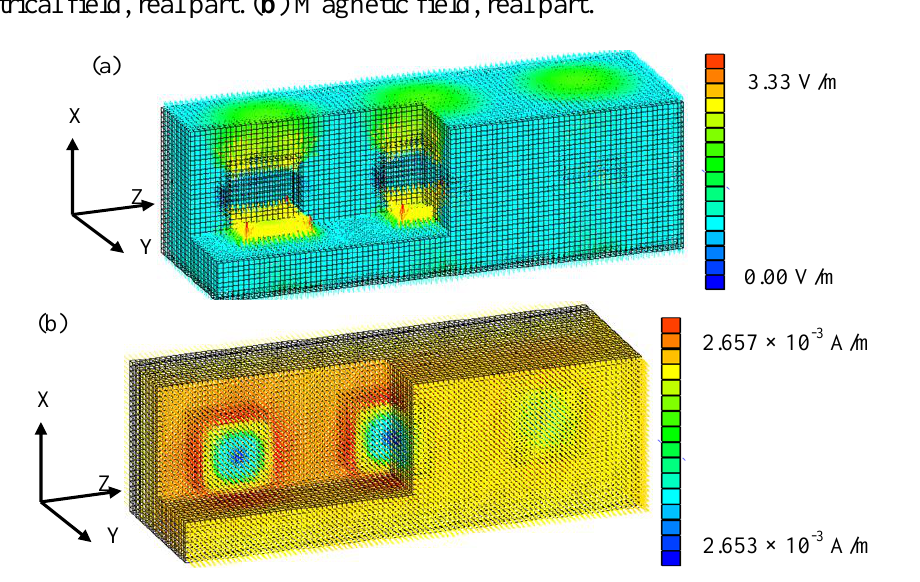
Figure 6. Electromagnetic field calculation result (aluminum, volume rate: 10%). ( a ) Electrical field, real part. ( b ) Magnetic field, real